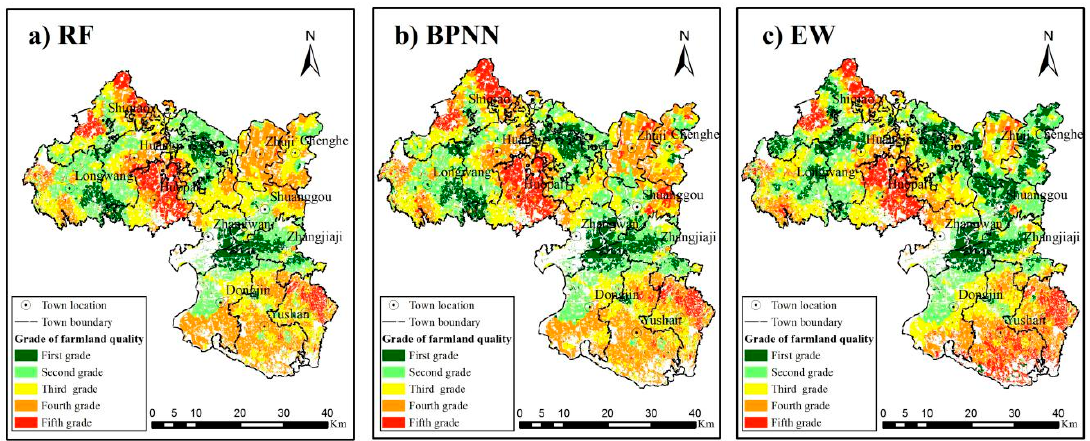
Figure 8. Spatial distribution of farmland quality grades: ( a ) Random forest (RF)—based, ( b ) Backpropagation neural network (BPNN)—based, and ( c ) Entropy weight (EW)—based.